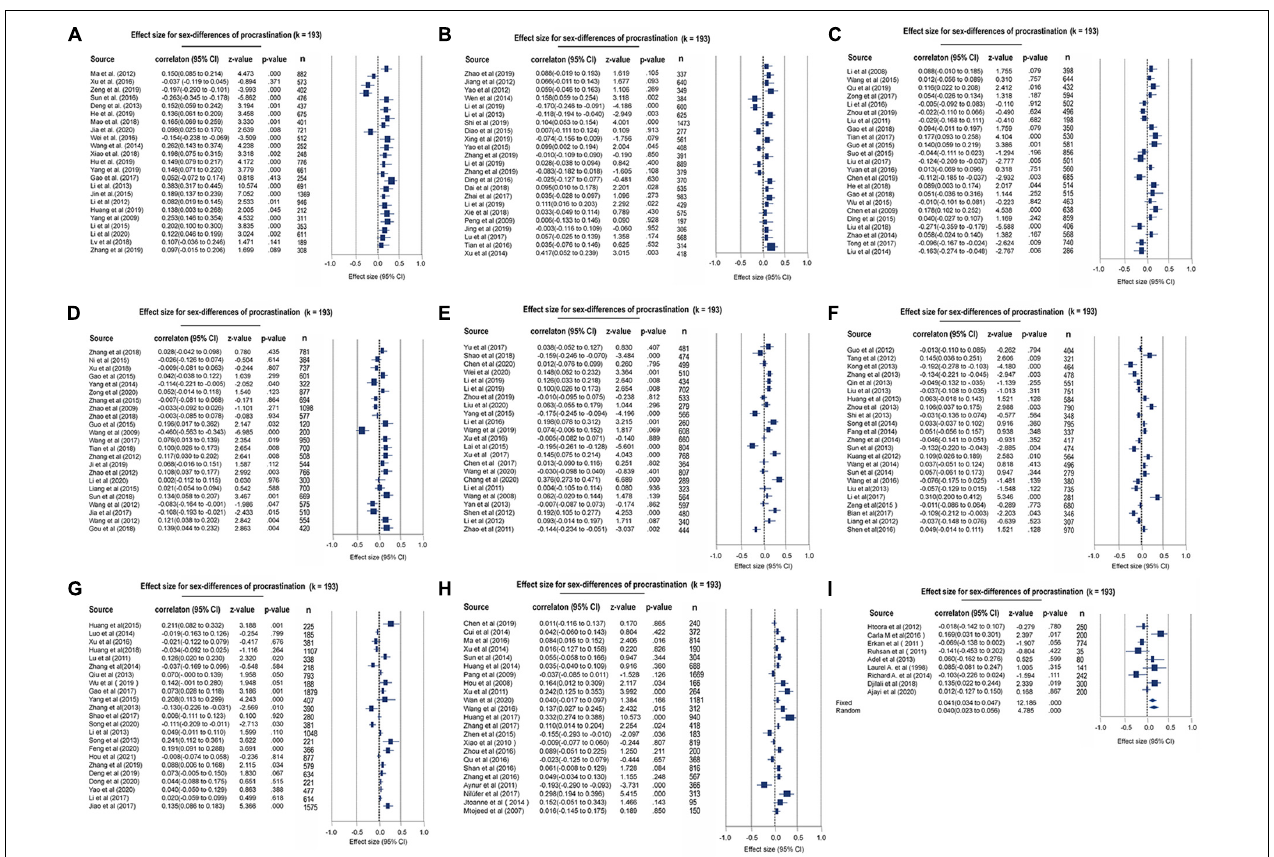
FIGURE 2 | Forest plot for the meta-analytic results toward gender differences of